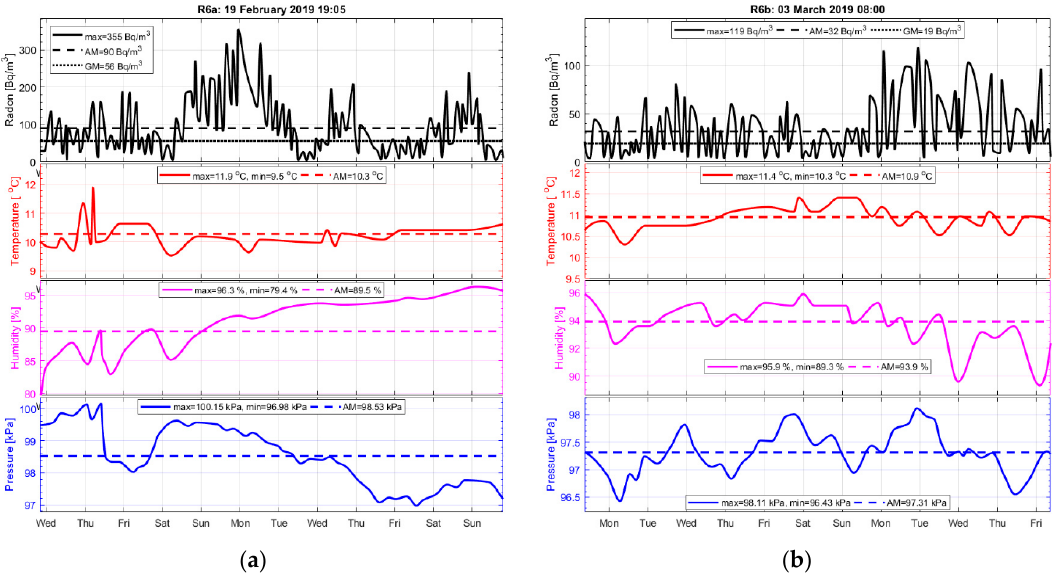
Figure 4. Radon measurements in wine cellar house (R6). ( a ) Basement-storage, ( b ) dining storage. For each floor, 4 sublots are shown within time and days of measurements: radon concentrations, indoor temperature, humidity and air pressure with arithmetic mean and geometric mean values shown in legend. Day tick marks 00:00 time.